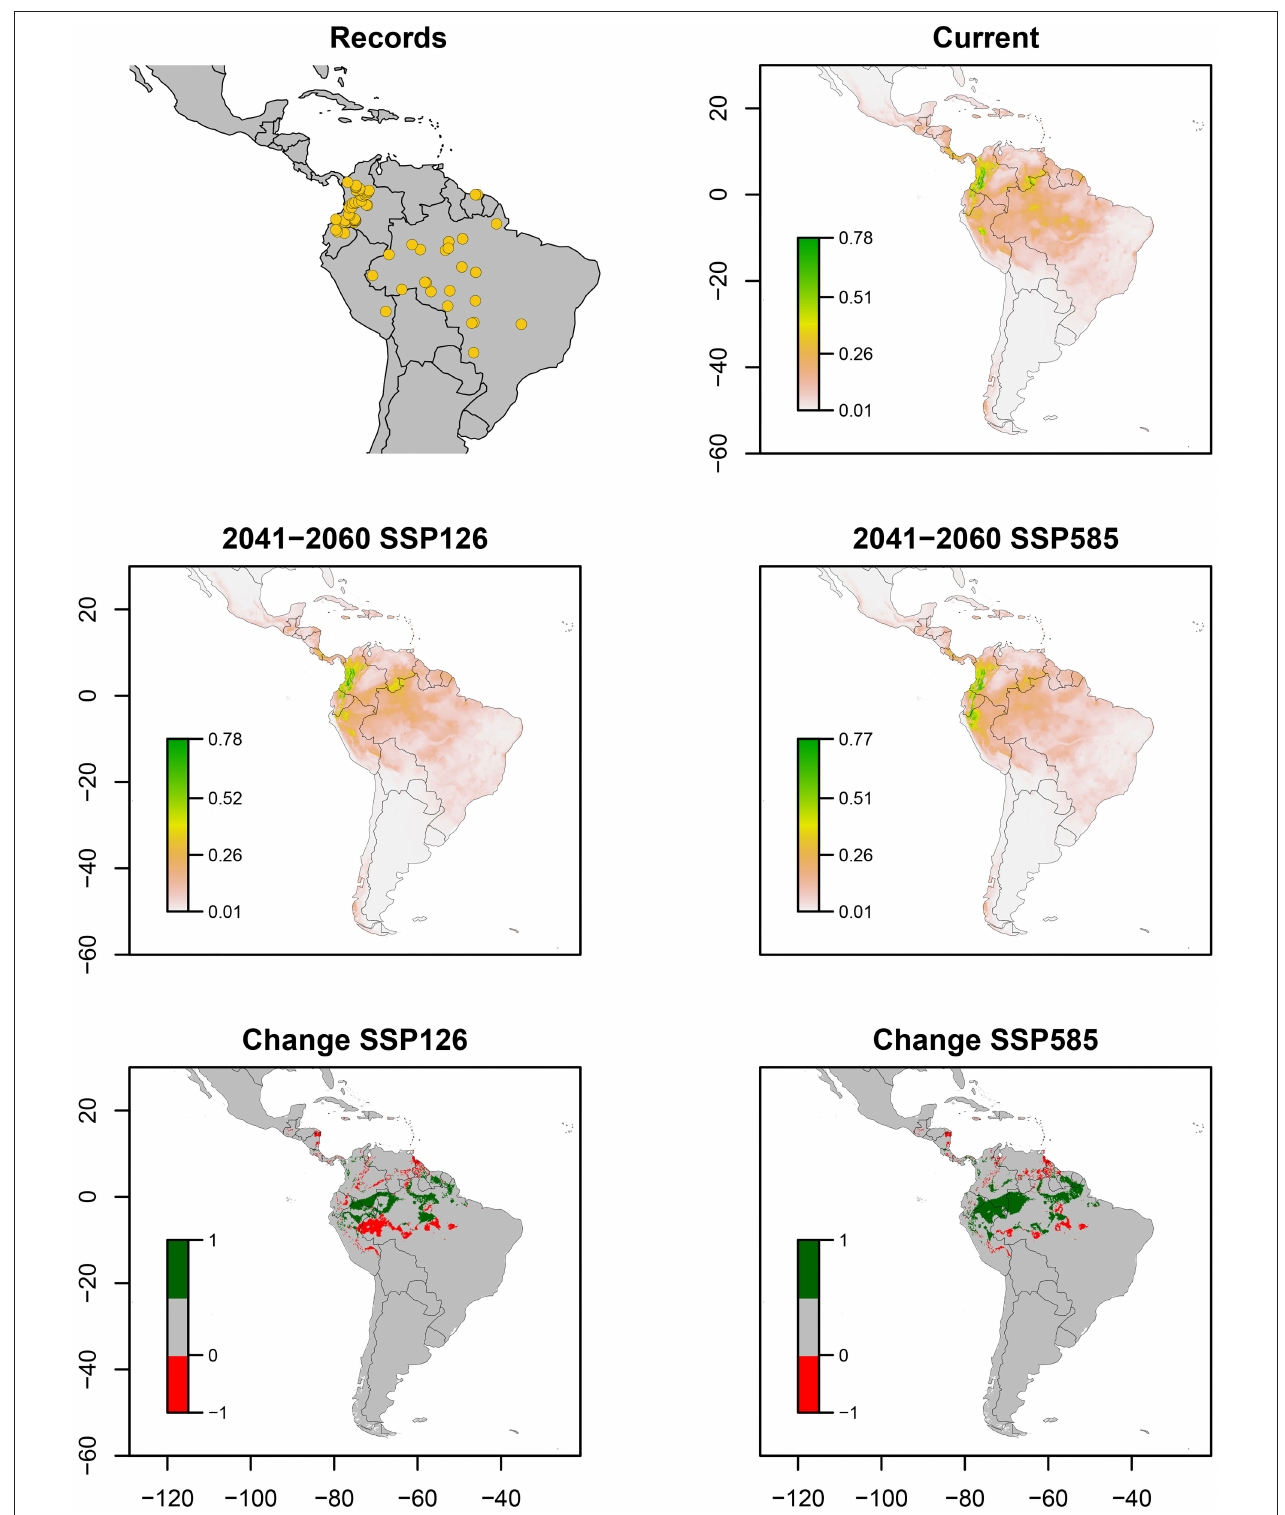
FIGURE 6 | Ecological niche models of Zulia pubescens. Distribution records, current potential distribution, future potential distribution (2041–2060) under SSP126 and SSP585 scenarios, and comparison between current and future scenarios (change SSP126 and SSP585). The scale shows the habitat suitability being 1 = higher suitability. Scale in change maps − 1 = possible extinction and 1 = possible